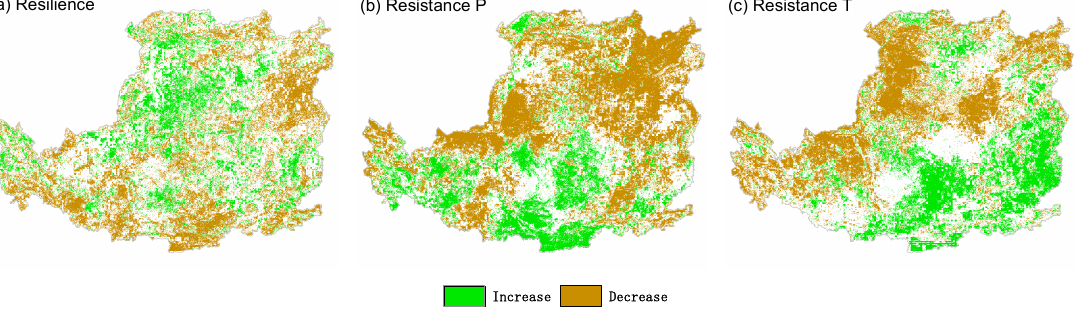
Figure 6. Temporal changes of resilience ( a ), resistance to P ( b ) and resistance to T ( c ) (green: increase, brown: decrease).